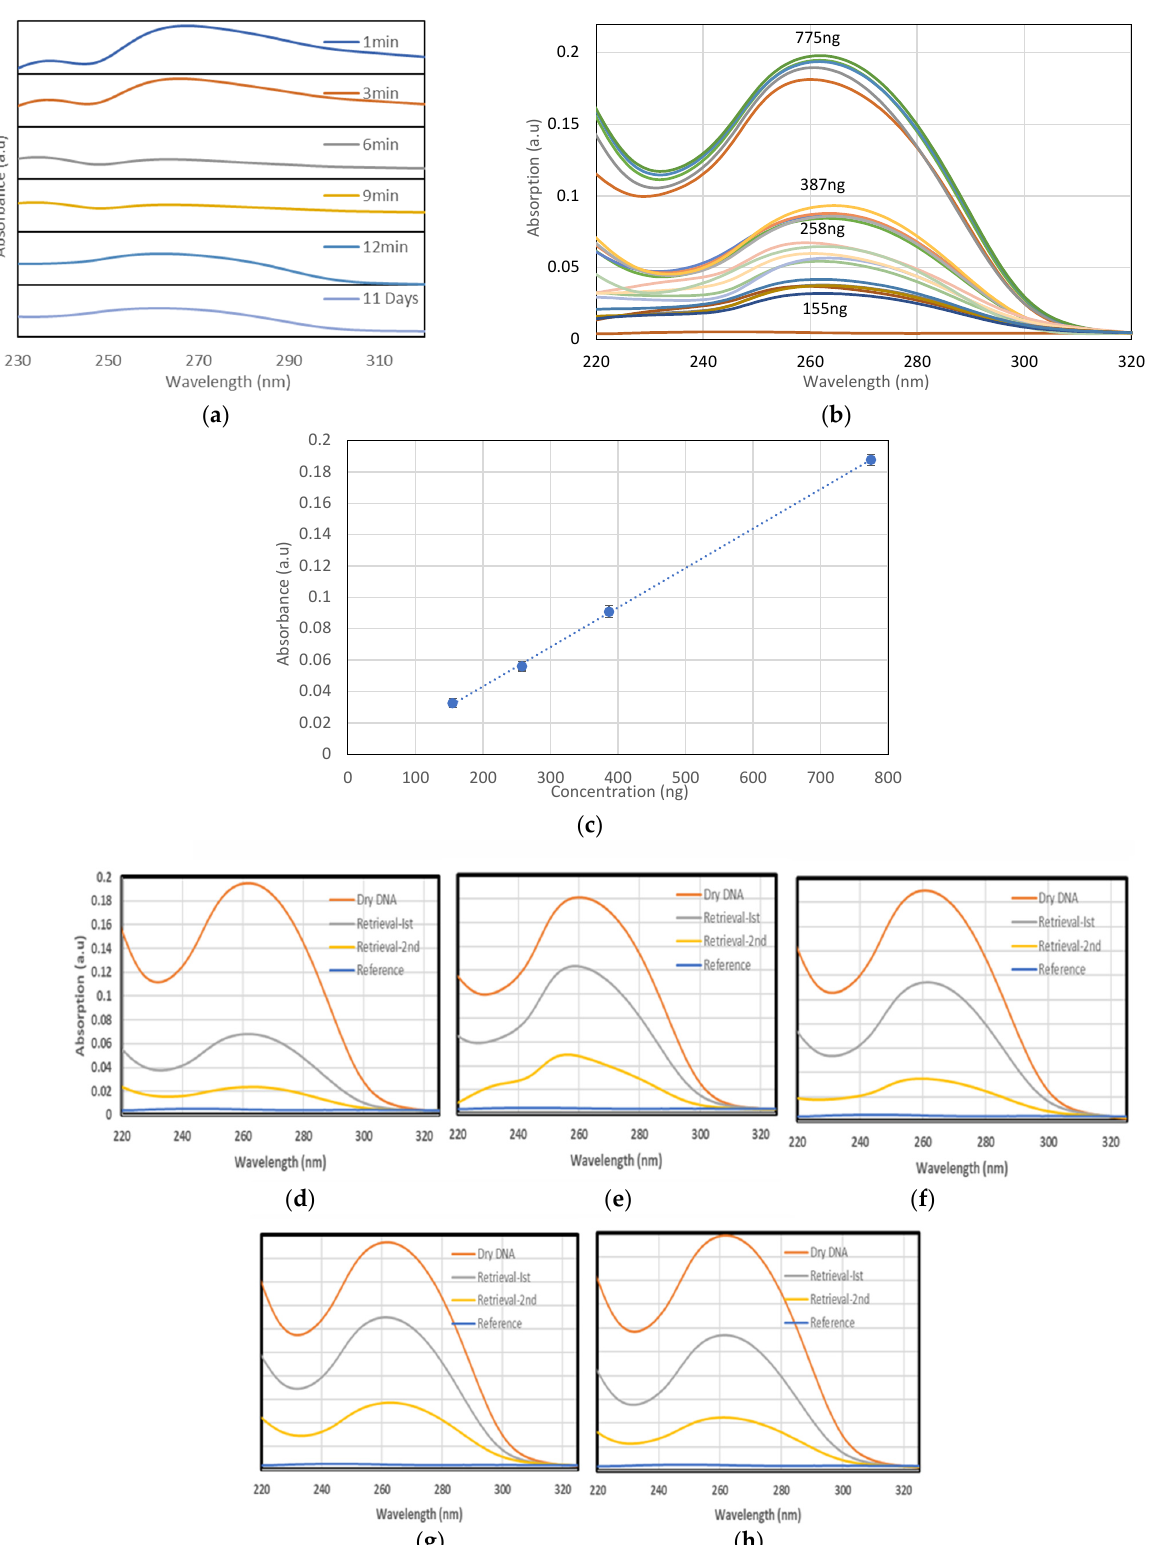
Figure 8. ( a ) Absorption spectra at different timings of the 2 µL droplet during the drying process at room temperature; ( b ) UV absorption of different amounts of dry-state DNA; ( c ) Peak absorbance values obtained for these concentrations; ( d – h ) Absorption spectra after drying, first and second retrieval of 775 ng DNA ( a ) first iteration, ( b ) second iteration, ( c ) third iteration ( d ) fourth iteration, and ( e ) fifth